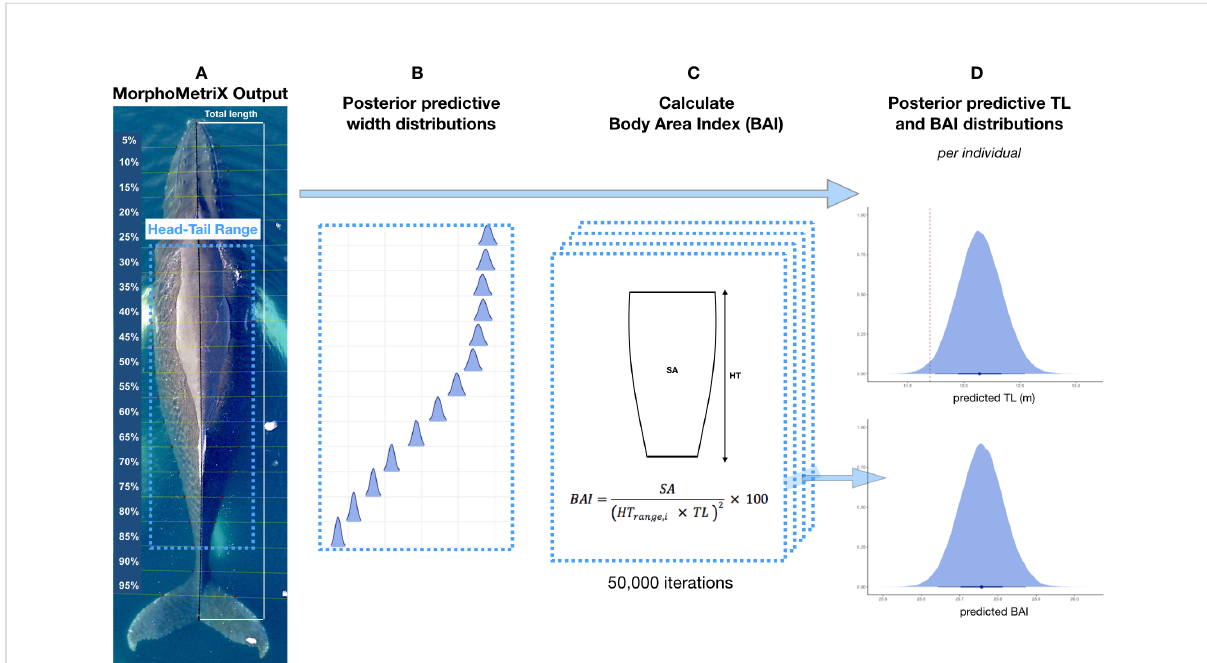
FIGURE 2 Overview of Bayesian framework for incorporating uncertainty associated with total length (TL) and Body Area Index (BAI). (A) An example of a MorphoMetriX output (Torres and Bierlich, 2020) from a UAS image of a humpback whale. TL is measured as rostrum to fl uke notch with perpendicular widths in 5% increments of TL. The Head-Tail Range represents the region of the body used to calculate BAI, and excludes the head, tail, and fi ns ( juvenile and adults = 25-85%, calves = 20-85%). (B) Posterior predictive distributions for each 5% width included in the Head-Tail Range are generated and used to calculate BAI. (C) BAI is calculated for each iteration in the Markov Chain Monte Carlo output of each posterior predictive distribution for TL and widths using CollatriX (Bird and Bierlich, 2020). (D) An example of a posterior predictive distribution for TL and BAI for a single individual. On the x-axis, the black dot represents the mean value and uncertainty is represented by the 95% highest posterior density (HPD) intervals (longer black bars) and the 65% HPD intervals (thicker shorter black bars). The red dashed line represents the maturity cutoff length ( female = 11.73, male = 11.20, unknown = 11.47 m ). Figure adapted from Bierlich et al., 2021a and Torres et al.,